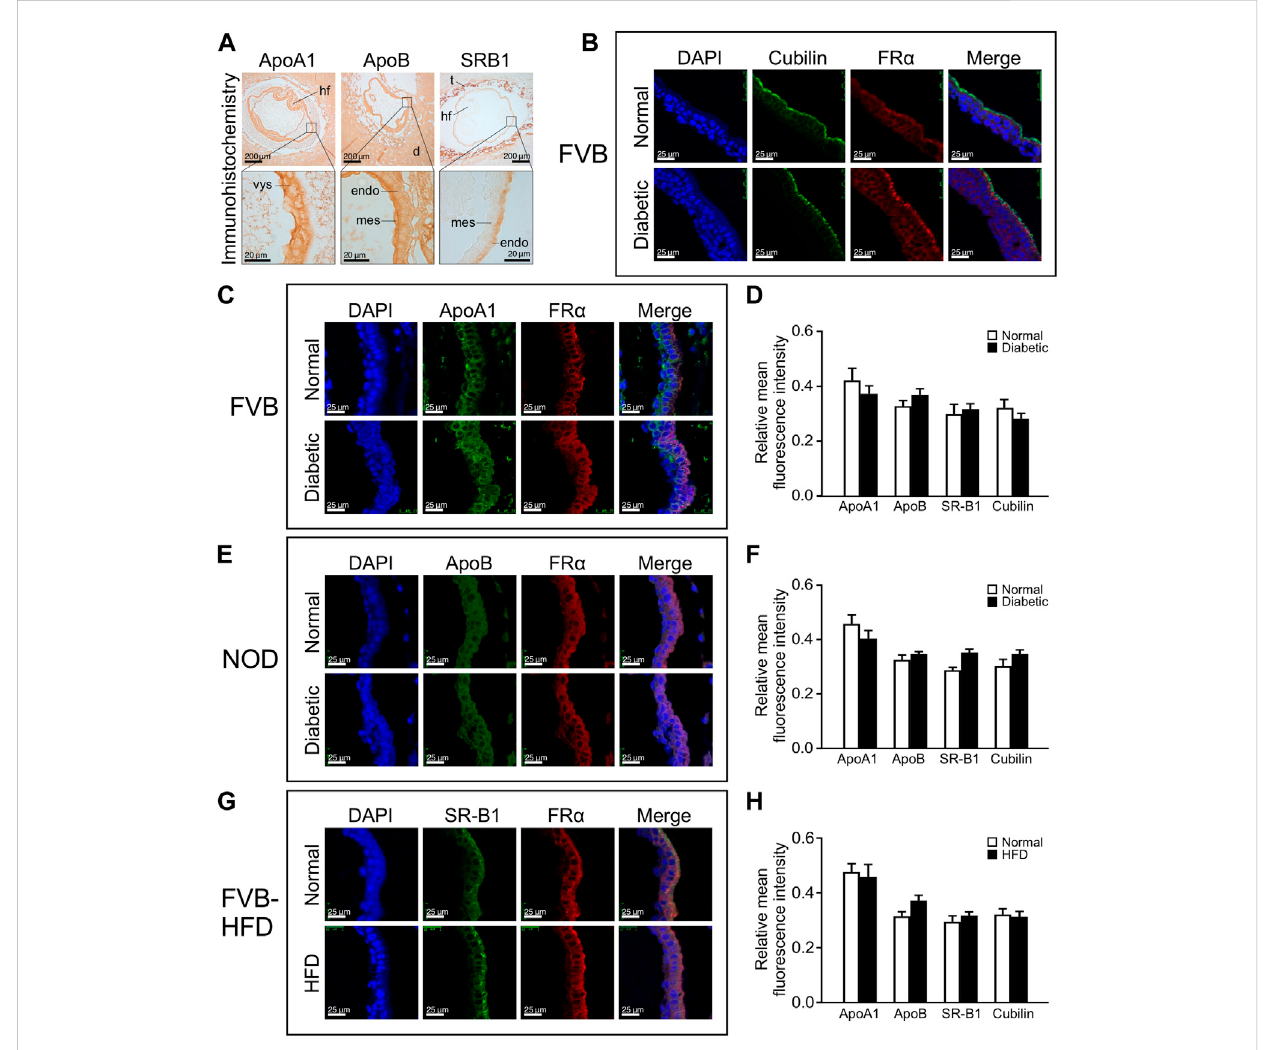
FIGURE 4 Lipid transporter protein expression in yolk sacs is unaffected by maternal metabolic disease or high fat diet-feeding. Expression of lipid transporter proteins was detected by immunohistochemistry and immuno fl uorescence on serial sections from paraf fi n-embedded whole decidua isolated at E8.5. The apical surface of the endodermal layer of the yolk sac is facing towards the right in all images. Panel A: Immunohistochemical staining for ApoA1, ApoB, and SR-B1 in specimen from a normal FVB pregnancy. Areas of magni fi cation (lower images) are indicated by frames in the upper images. Abbreviations:hf=headfold ofembryo;d=deciduum;t=trophoblast layer;vys=visceral yolksac; mes=mesodermallayerofvisceralyolksac; endo= endodermal layer of visceral yolk sac. Panel B : Positive identi fi cation of the endodermal layer of the visceral yolksac by immuno fl uorescence staining for Cubilin and Folate Receptor 1 (here detected with an antibody against FR α ). Cubilin is very selectively located only on the apical surface of the visceral endoderm, whereas Folate Receptor 1 staining detects the entire endoderm layer and was therefore used in all immuno fl uorescence assays. Panel C : Immuno fl uorescencedetection ofApoA1expressioninyolksacfromFVBpregnantmice. ApoA1expressionispresentinendodermal,FolateReceptor1- positive cells as well as FolR1-negative cells of mesodermal origin. Panel D : Quanti fi cation of fl uorescence for each lipid transporter relative to the DAPI signal intensity in cells expressing the respective protein. No signi fi cant differences were found for lipid transporter expression between yolk sacs from diabetic compared to normoglycemic FVB dams. N = six to eight samples from 3 normoglycemic FVB pregnancies, n = seven to nine samples from 2diabeticFVBpregnancies,samplenumbersvarieddependingonproteininvestigated.Panel E :Immuno fl uorescencedetectionofApoBinyolksacfrom NOD pregnant mice. Panel F : Quanti fi cation of relative expression levels did not reveal statistically signi fi cant differences in yolk sac lipid transporter expression between diabetic and normoglycemic NOD pregnancies. N = 7 – 20 samples from 3 normoglycemic NOD pregnancies, n = 3 – 16 samples from 2 diabetic NOD pregnancies. Panel G : Immuno fl uorescence detection of SR-B1 expression in yolk sac from FVB dams where one group had been fed a high fat diet for 4 weeks prior to mating and until sacri fi ce. SR-B1 signal is predominantly located at the apical surface of the endodermal cells layer, coincident with enriched Folate Receptor 1 localization. An apparently stronger signal for SR-B1 in the HFD condition was only detected in this sample, and was not consistent after quanti fi cation of multiple specimen (see Panel H). N = 12 – 15 samples from chow-fed FVB pregnancies, n = 8 – 17 samples from high-fat-diet-fed FVB pregnancies. Panel H : Quanti fi cation of relative expression levels did not reveal statistically signi fi cant differences in yolk sac lipid transporter expression between high-fat-diet-fed and chow-diet-fed dams. Results were fi rst averaged over each pregnancy and then the respective experimental group, presented as mean ± SD, and statistical signi fi cance at p < 0.05 would be indicated by asterisks if detected.